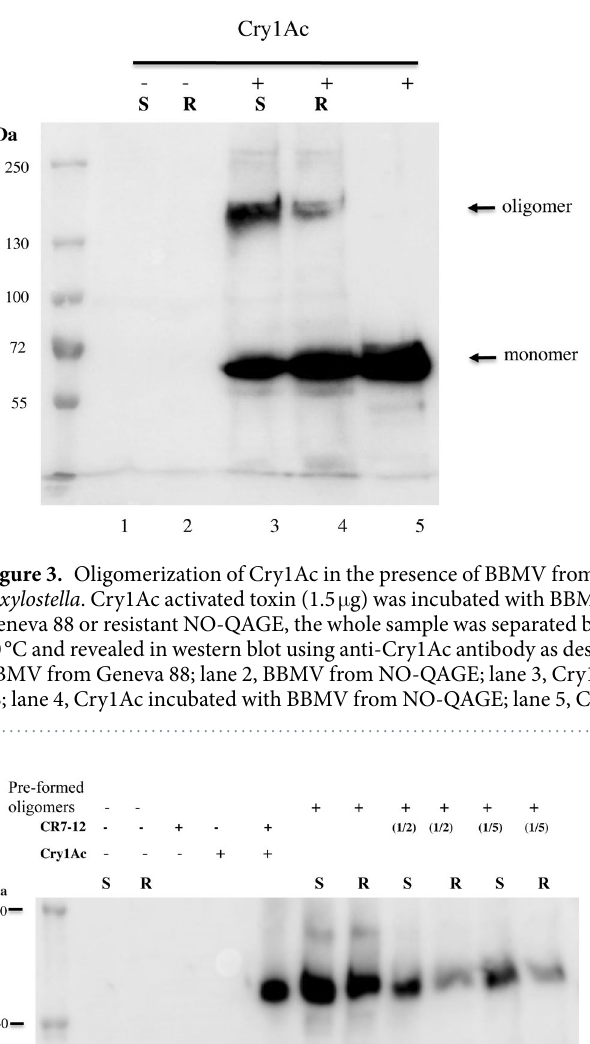
of Cry1Ac were incubated with BBMV to test for membrane insertion, the optical density of 200 kDa bands indicated that oligomers were slightly, but not significantly lower with BBMV from the resistant strain relative to BBMV from the susceptible strain (Fig. 4, Table S1, paired t-test, t = 1.3, df = 2, P = 0.33). By contrast, the optical density of 200 kDa bands was significantly greater for BBMV from the susceptible strain than for BBMV from